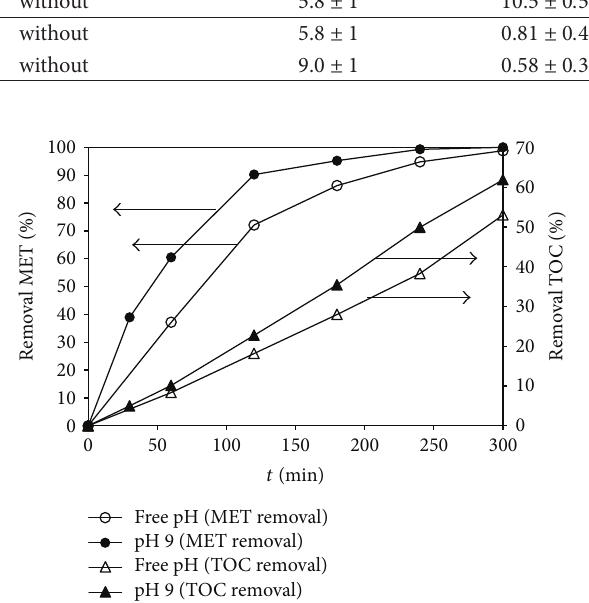
Figure 4: MET and TOC removal (%) versus time (min) at free pH and pH 9 in photocatalytic experiments.